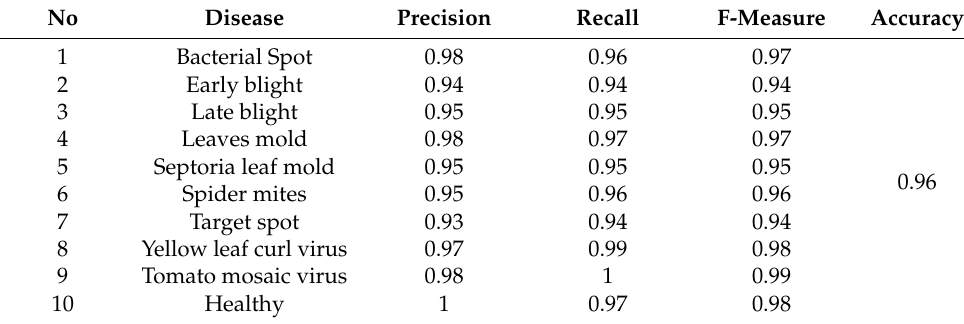
Table 5. Precision, Recall, and F1-Score Values of the